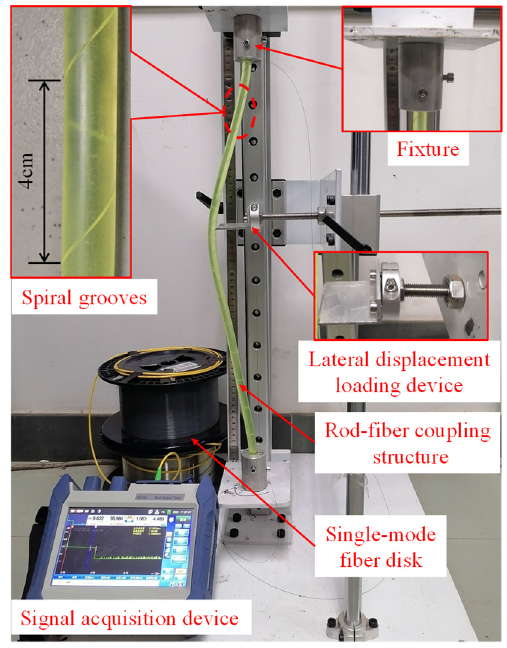
Figure 4. Scheme of the calibration